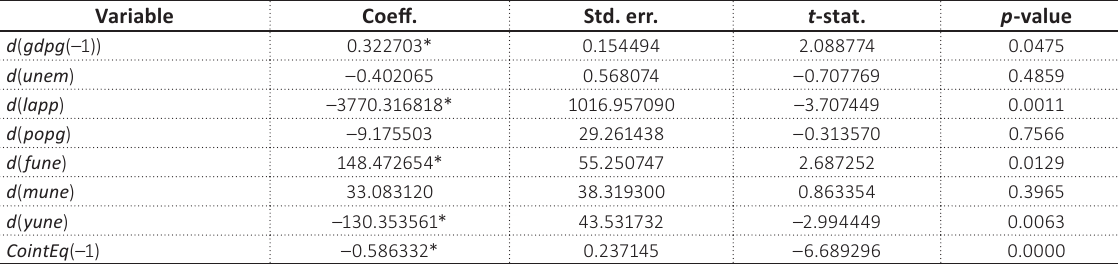
Table 5. ARDL estimates (long-run